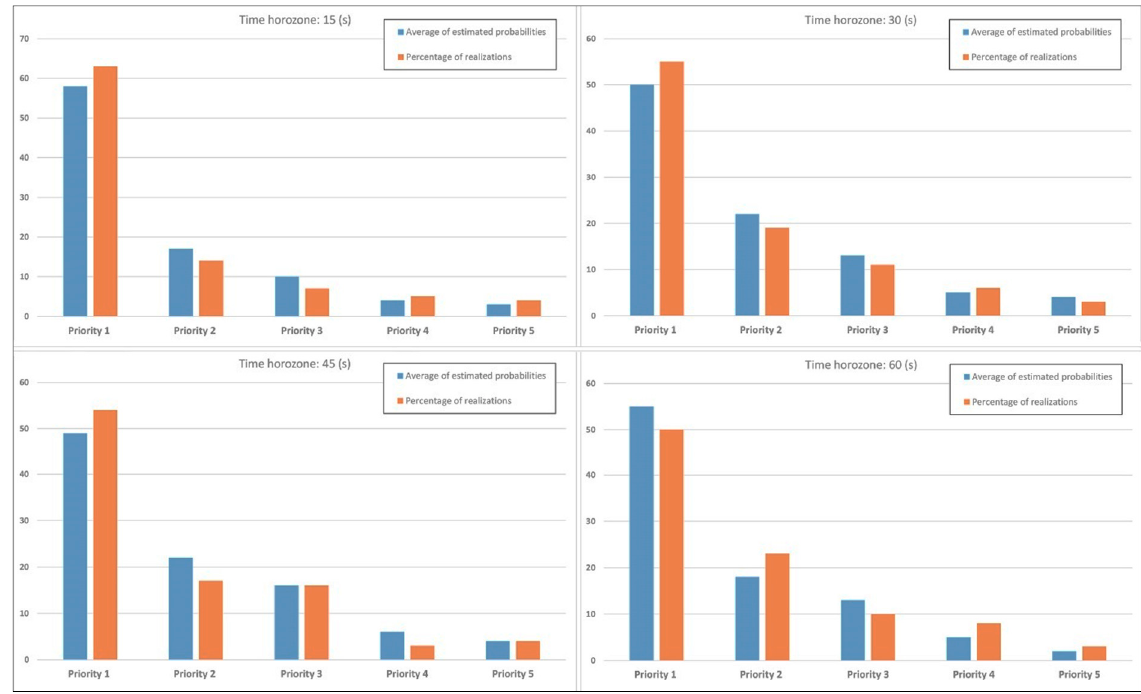
Figure 10. The average of estimated probabilities and the percentage of realizations in zones in different